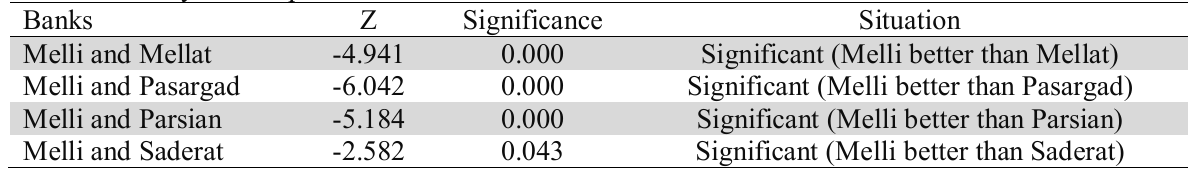
Mann-Whitney test for price Banks